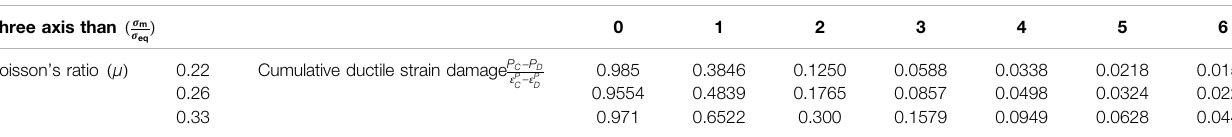
TABLE 4 | Cumulative ductile damage of rock under different strain